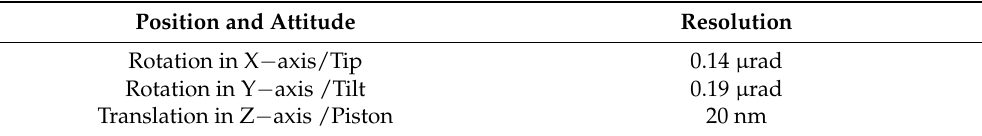
Table 6. 3 − DOF minimum resolution of piezoelectric platform.